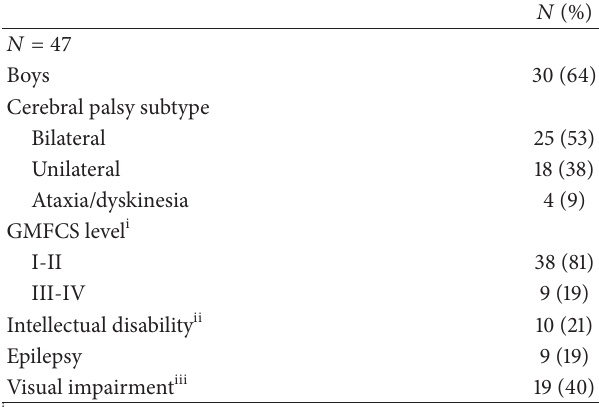
Table 1: Demographics and functional data for a population of chil- dren with cerebral palsy living in the Western Health Region of Norway at school starting